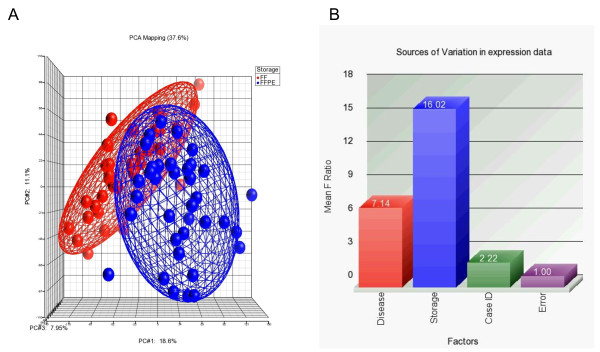
Principle components analysis (PCA) and sources of variation. Principle components analysis (PCA) of 71 samples displaying spatial separation (expression level clustering) of RNA extracted from FF samples (shown in red on left) and FFPE samples (shown in blue on right); The three principle components (PC#1, #2 & #3 and respective contributable variations are presented on x-, y- and z-axis along). A Statistical significance of the different "sources of variation" in the total gene expression estimated by 3-way ANOVA models. F ratio for each factor (source) represents the F-statistics for that factor/F-statistics for error (noise). The mean of the F Ratio for all the genes for a particular factor are shown on Y-axis and the different factors (sources of variation) are shown in x-axis.